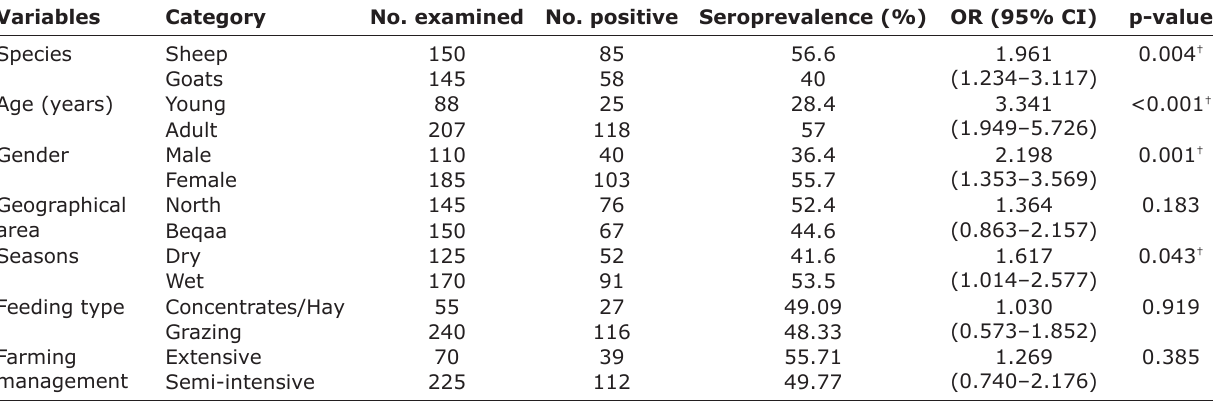
Table-1: Seroprevalence and associated risk factors of T. gondii infection in sheep and goats in Lebanon. Variables